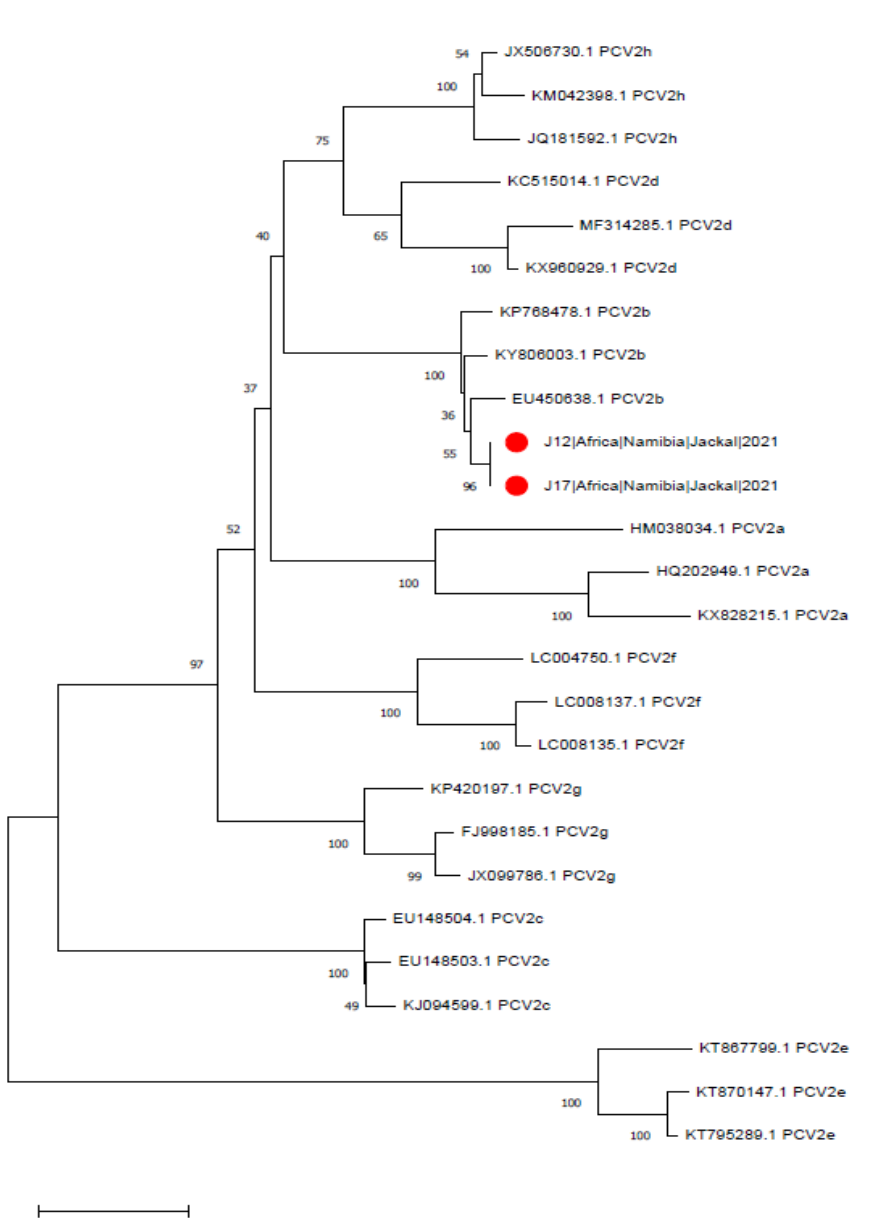
Figure 1. Maximum-likelihood phylogenetic tree based on complete ORF2 gene sequences of PCV- 2 strains obtained in the present study (highlighted by red circles) and the reference sequences suggested by Franzo and Segalés (2018). The numbers nearby each node report the corresponding branch support.